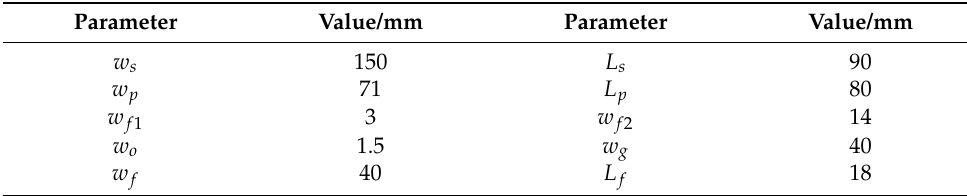
Table 1. The optimal values of the overall parameters of the antenna. Parameter Value/mm Parameter